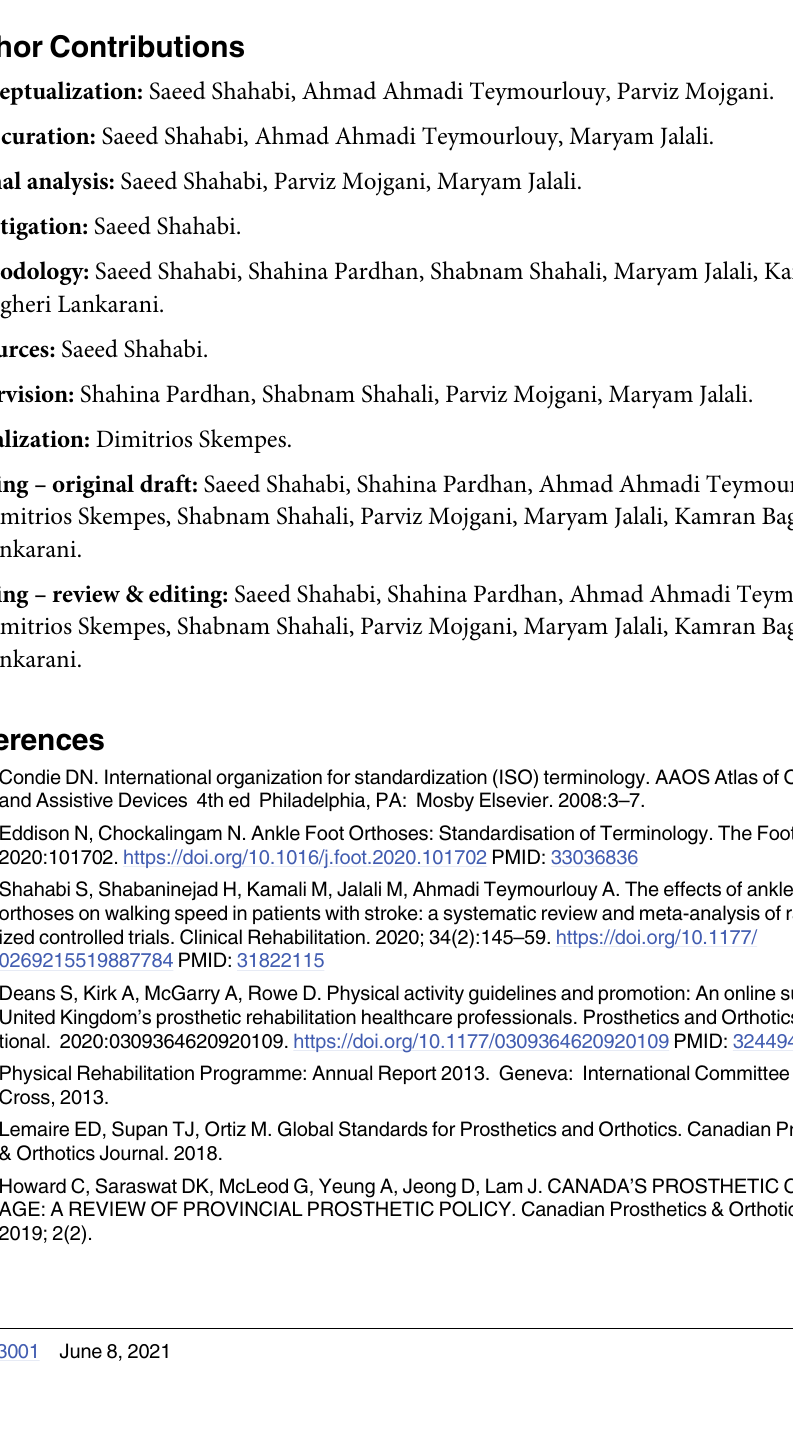
S1 Table. Characteristics of